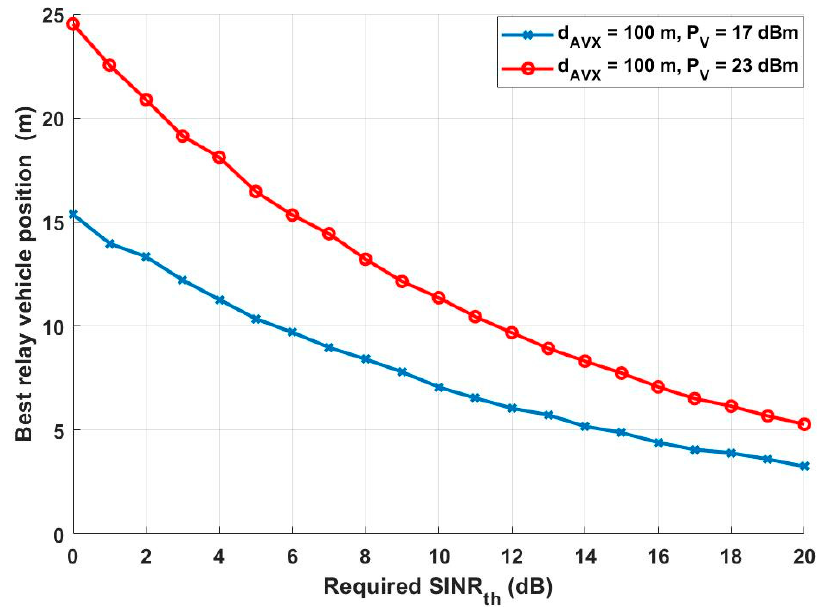
Figure 4. Required SINR thVX vs. best relay-vehicle position.